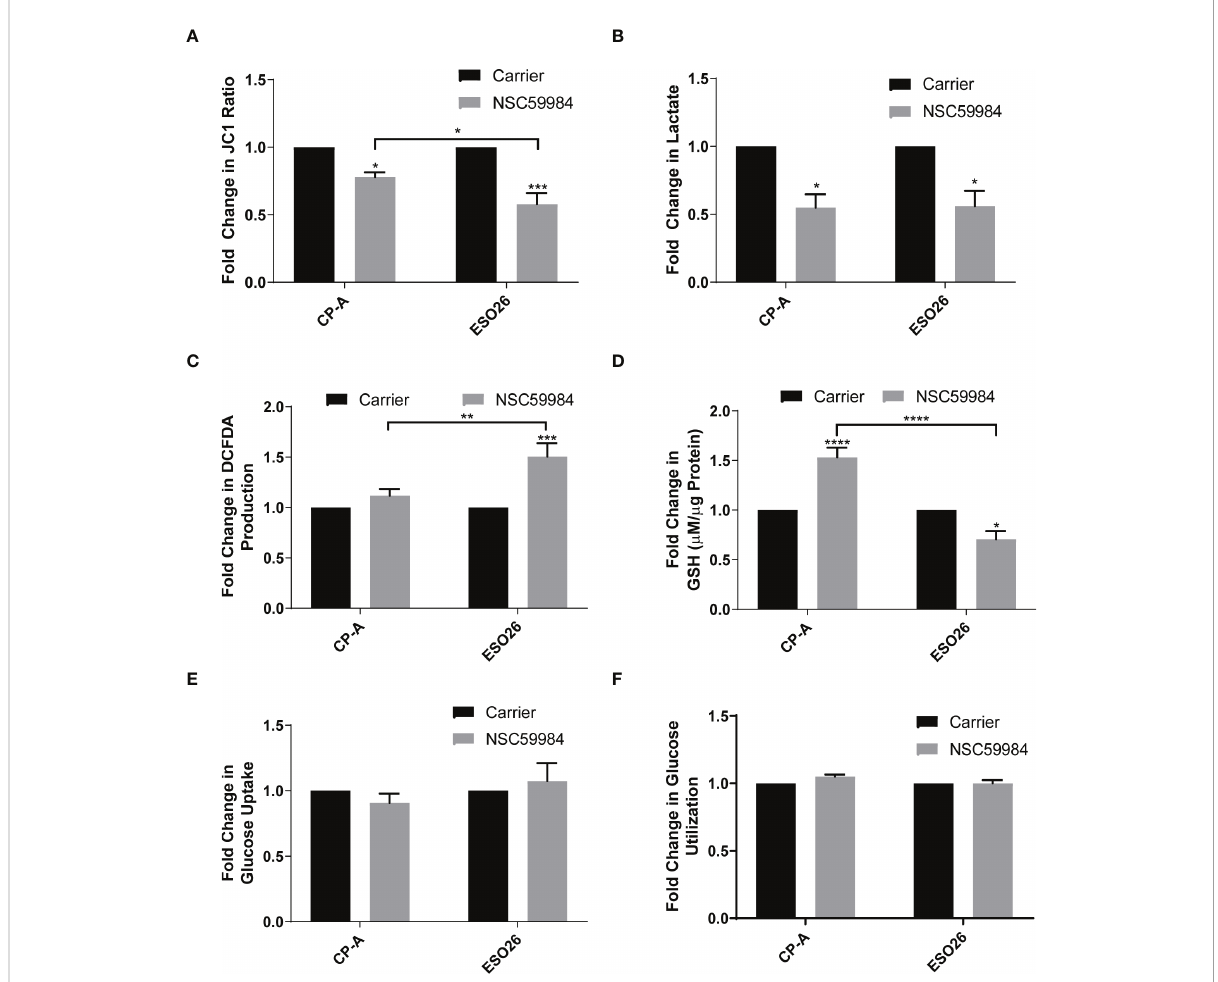
FIGURE 4 Effects of NSC59984 treatment on speci fi c aspects of mitochondrial function. (A) Analysis of mitochondrial membrane potential ( DY m) as measured by the ratio of JC-1 fl uorescence following treatment with NSC59984 (12 m M) for 72 hr over carrier control in EAC cells. Fold change in carrier-treated cells was normalized to 1. (B) Fold-change in lactate secretion (mM per µg of cellular protein) following treatment with NSC59984 (12 m M) for 72 hr over carrier control in EAC cells. Fold change in carrier-treated cells was normalized to 1. C. Fold-change in total ROS levels (DCFDA) following treatment with NSC59984 (12 m M) for 72 hr over carrier control in EAC cells. Fold change in carrier-treated cells was normalized to 1. (D) Fold-change in total GSH level (µM GSH per µg of cellular protein) following treatment with NSC59984 (12 m M) for